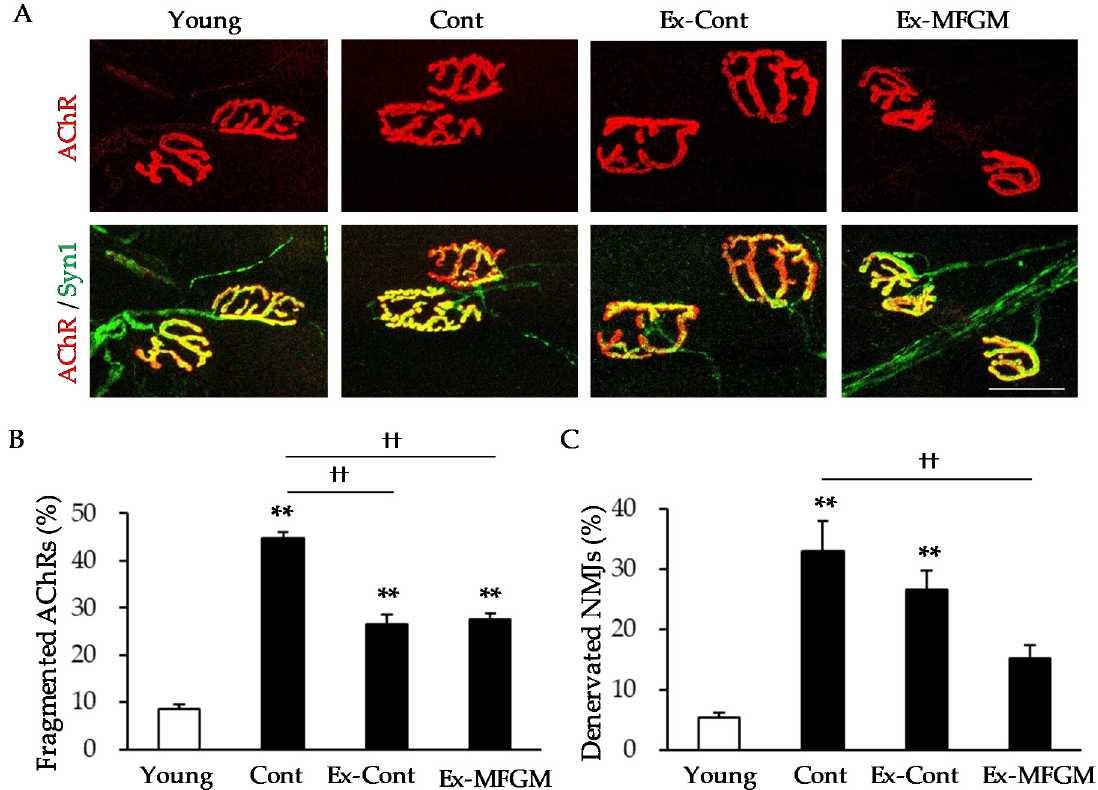
Figure 4. The effect of MFGM intake with exercise from an old age on age-related NMJ alterations. ( A ) Representative NMJ images at 10 months old (Young) and 24 months old (Cont, Ex-Cont, Ex-MFGM) are shown. Postsynaptic AChRs were stained with fBTX (red), and presynaptic nerve terminals were stained with antibodies against synapsin I (green). Scale bar: 50 µm. The percentages of fragmented AChRs ( B ) and denervated NMJs ( C ) were calculated. Values are presented as the mean ± SE ( n = 4–7 in each group). ** p < 0.01 vs. Young group; †† p < 0.01 vs. Cont group by Tukey’s test. AChR, acetylcholine receptor; fBTX, fluorescently tagged α -bungarotoxin; MFGM, milk fat globule membrane; NMJ, neuromuscular junction; Syn1, synapsin I; Young, young group; Cont, control diet group; Ex-Cont, control diet with exercise group; Ex-MFGM, milk fat globule membrane diet with exercise group.